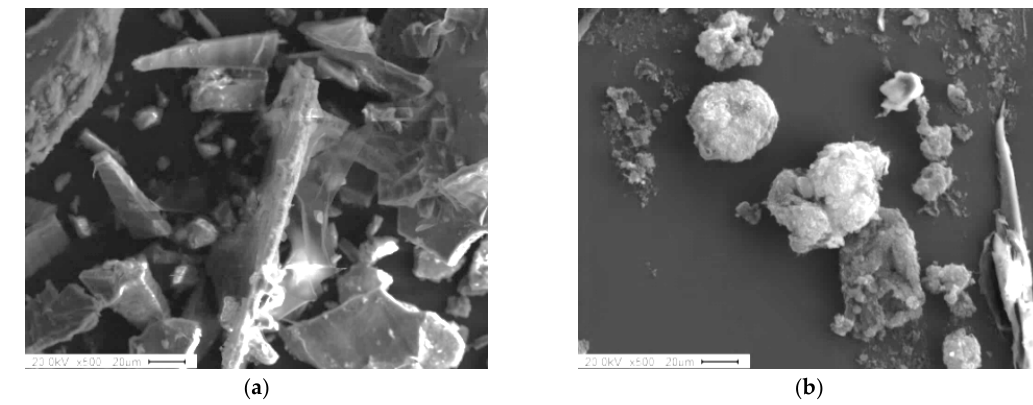
Figure 3. SEM micro images of abrasive tools used in wire magnetic abrasive finishing process. ( a ) SEM